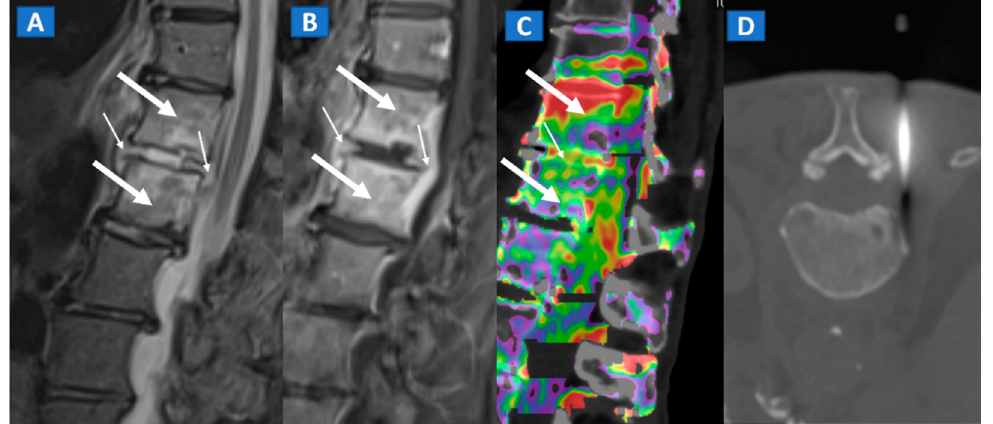
Figure 10. A 57-year-old male diagnosed with spondylodiscitis, and presenting with worsening low back pain. On the sagittal STIR MRI image ( A ), BME of the L1 and L2 vertebral bodies is apparent (thick arrows). The intervertebral disc appears hyperintense, with thickening of the anterior and posterior longitudinal ligaments (thin arrows). On the corresponding sagittal T1-weighted image ( B ) after intravenous administration of gadolinium, contrast enhancement is depicted, involving vertebral bodies (thick arrows) and thickened anterior and posterior longitudinal ligaments (thin arrows). On the DECT sagittal 1 mm reconstructed image ( C ), there is BME involving vertebral bodies (thick arrows) and the disc (thin arrow). Under CT guidance ( D ), sampling on para-spinal fluid collection was performed to confirm the diagnosis of spondylodiscitis and to isolate the pathogen involved.